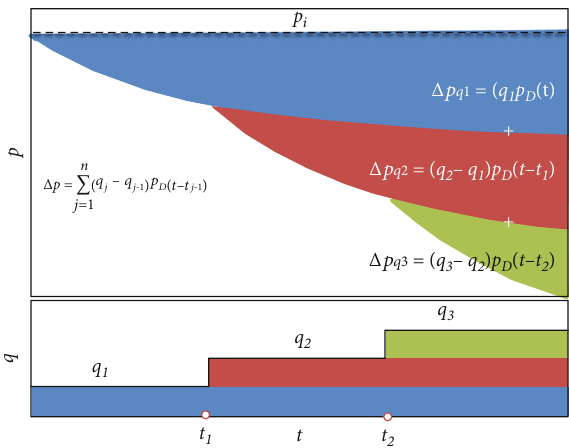
Figure 6: The process of Duhamel convolution.